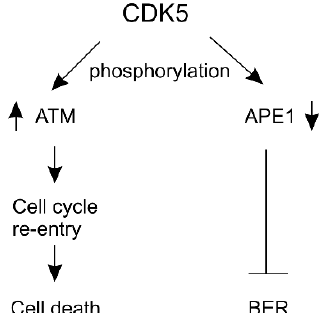
Figure 5. An illustration shows the effects of CDK5 in regulating DNA repair in neurons. Arrows indicate enhancing (upward direction) and reducing (downward direction) the protein’s functions respectively. CDK5 activity towards ATM in neurons is likely via p25. APE ‐ 1: AP (apurine/apirimidine) endonuclease 1; ATM: ataxia ‐ telangiectasia mutated; BER: base excision repair; CDK5: cyclin ‐ dependent kinase 5.